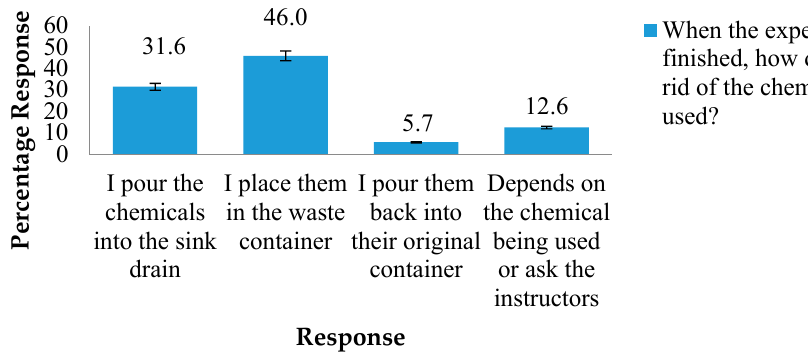
Figure 4. Percentage distribution of students’ response for the question on chemical safety practice (Question 27).